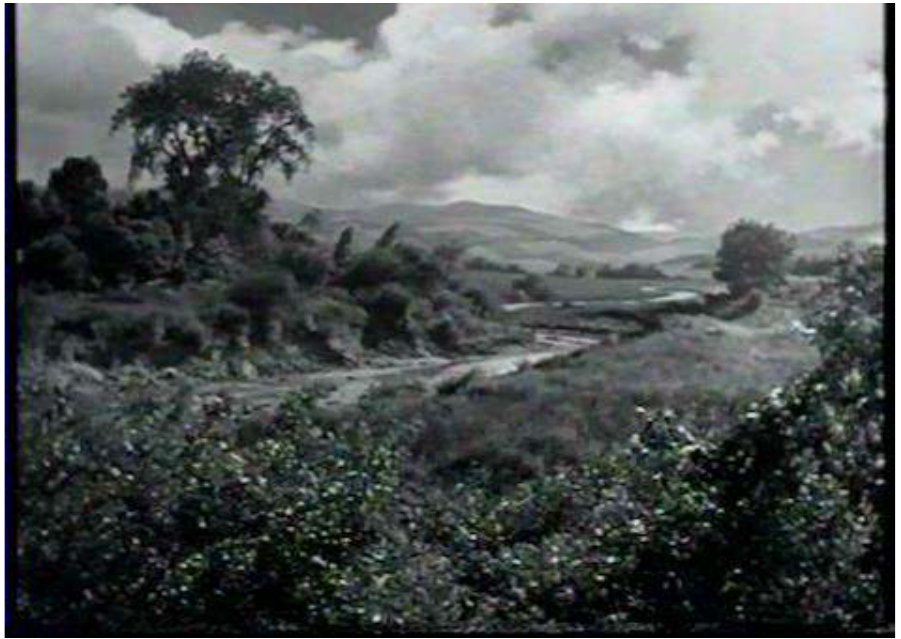
Figure 10: The fertile plains of Missouri at the start of Colorado Territory